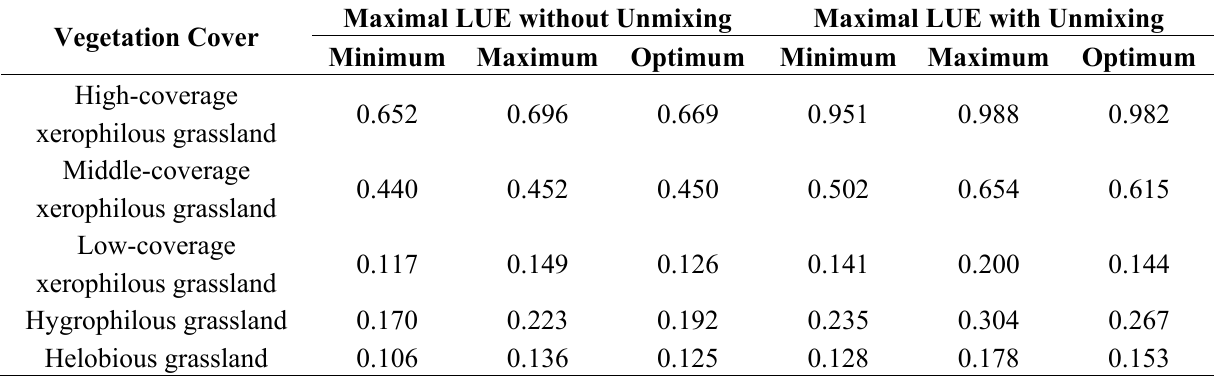
Table 2. The derived maximum light use efficiency (LUE) (gC·MJ − 1 ) of different vegetation covers on the Zoige